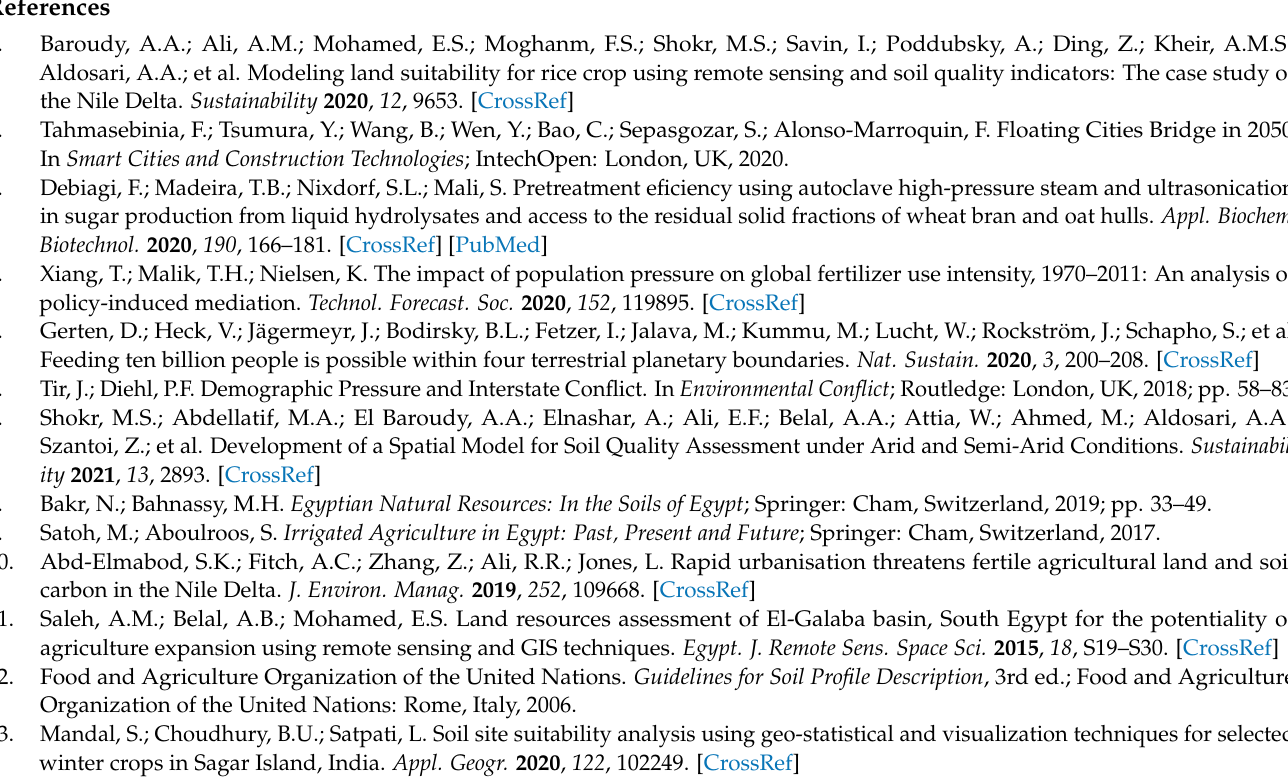
Table S2: Final SC range of study area; Table S3: Statistical characterization of the weighted mean of the studied soil profiles properties ( n =